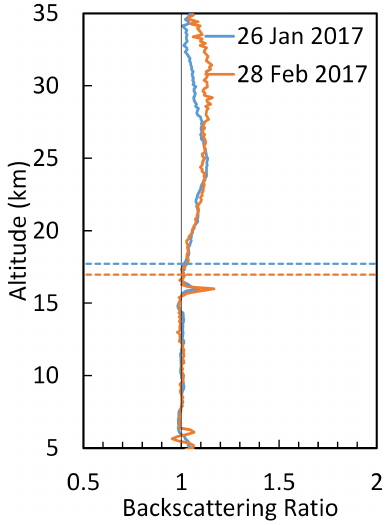
Figure 4. Backscattering ratio ( R ) profiles at 532 nm observed over Burgos on 26 January 2017 and 28 February 2017. The dashed lines represent the tropopause levels at 17.7 km and 17.0 km for the respective